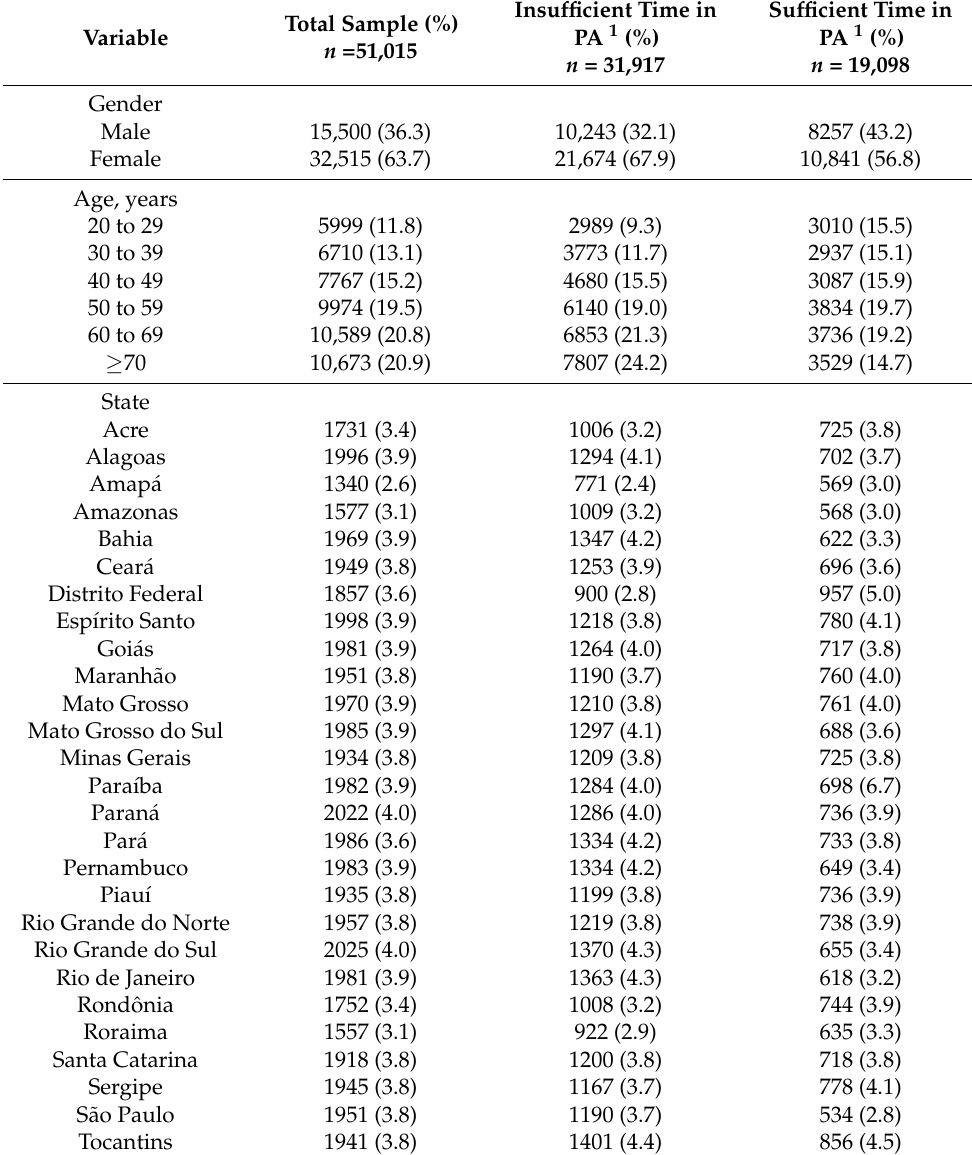
Table 1. Sociodemographic characteristics of the VIGITEL